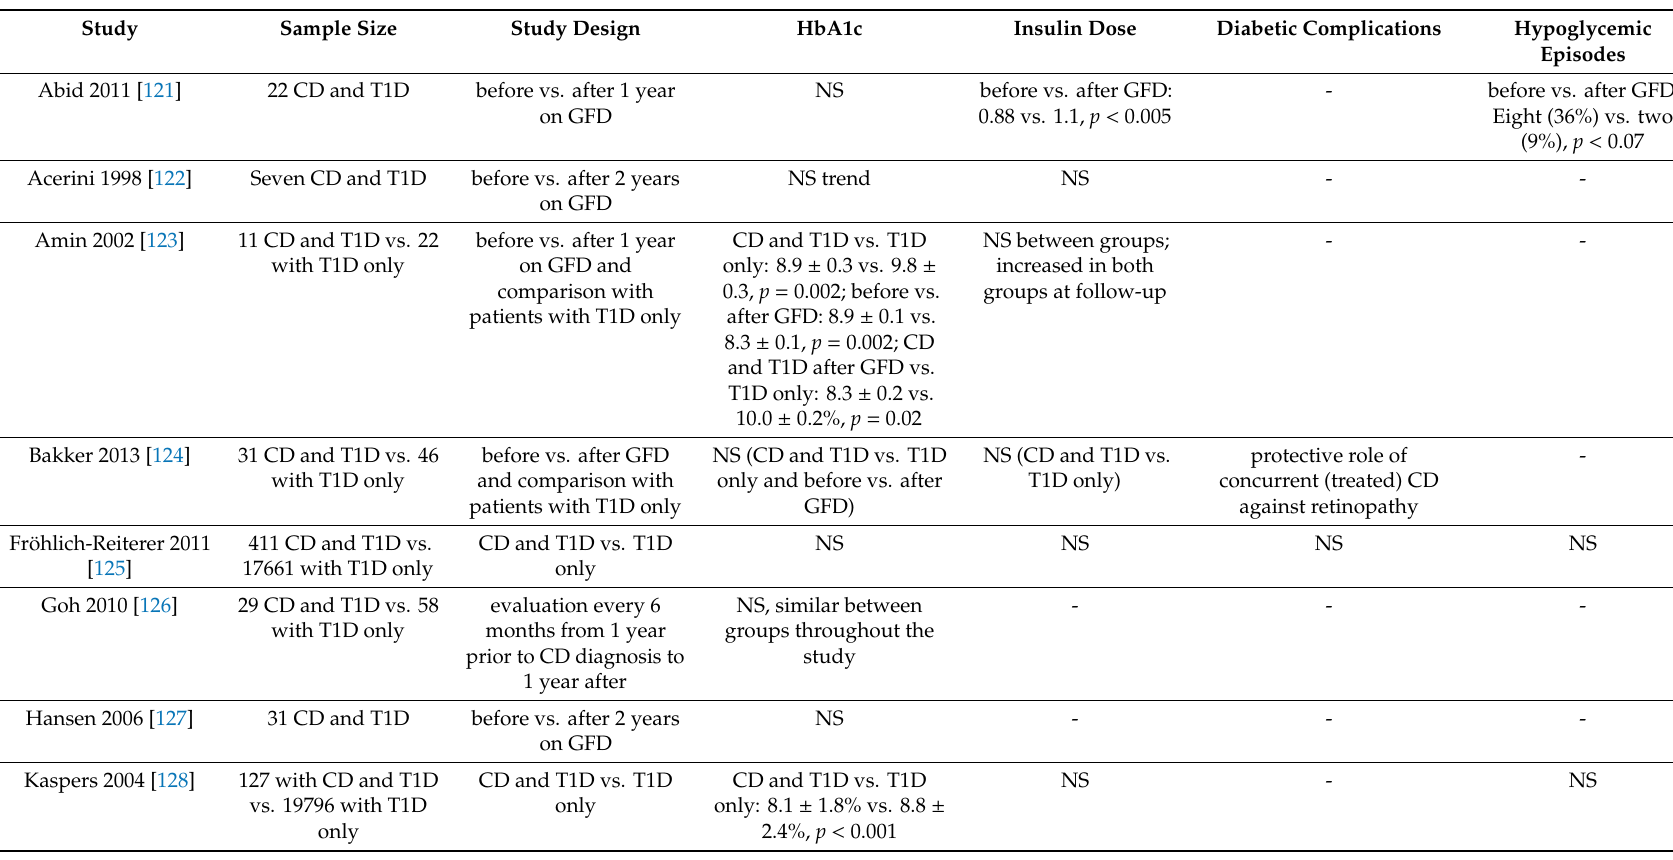
Table A1. Metabolic control and e ff ects of a GFD in patients with concomitant T1D and CD. CD: celiac Disease, GFD: gluten-free diet, NS: not significant, T1D: type 1